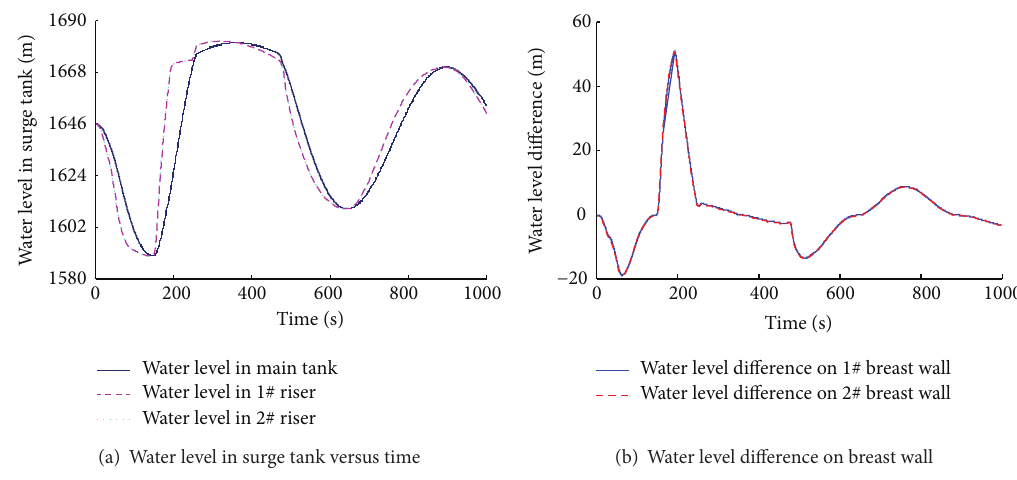
Figure 6: Numerical results of simultaneous load rejection after load